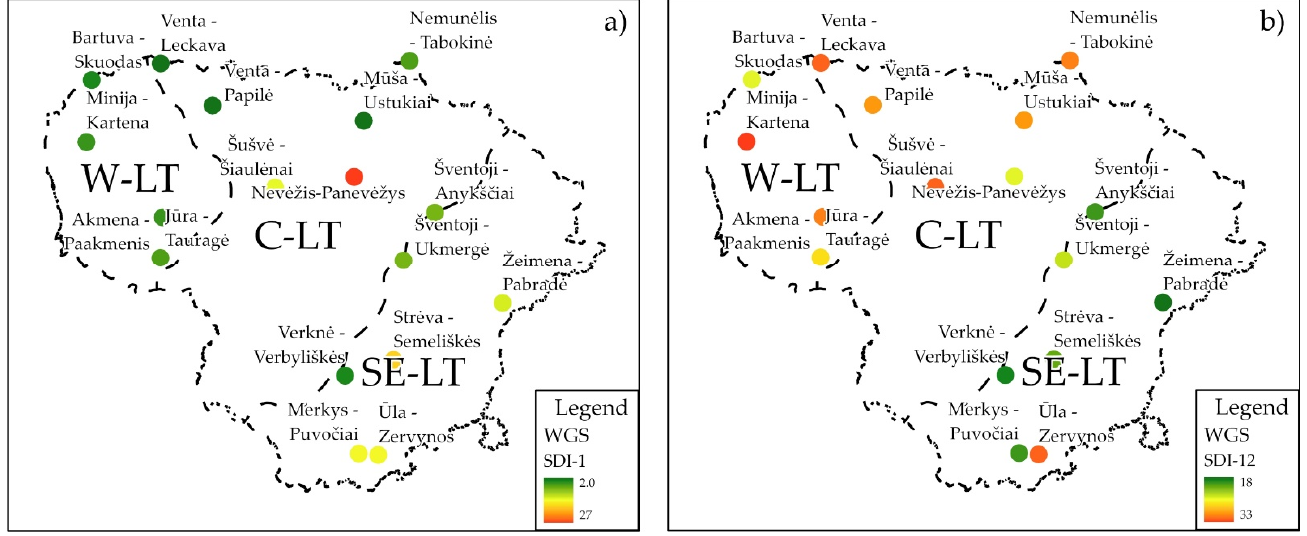
Figure 9. Distribution of rivers according to the number of driest months in the warm period for: ( a ) SDI index with 1-month accumulation period; ( b ) SDI index with 12-month accumulation period.